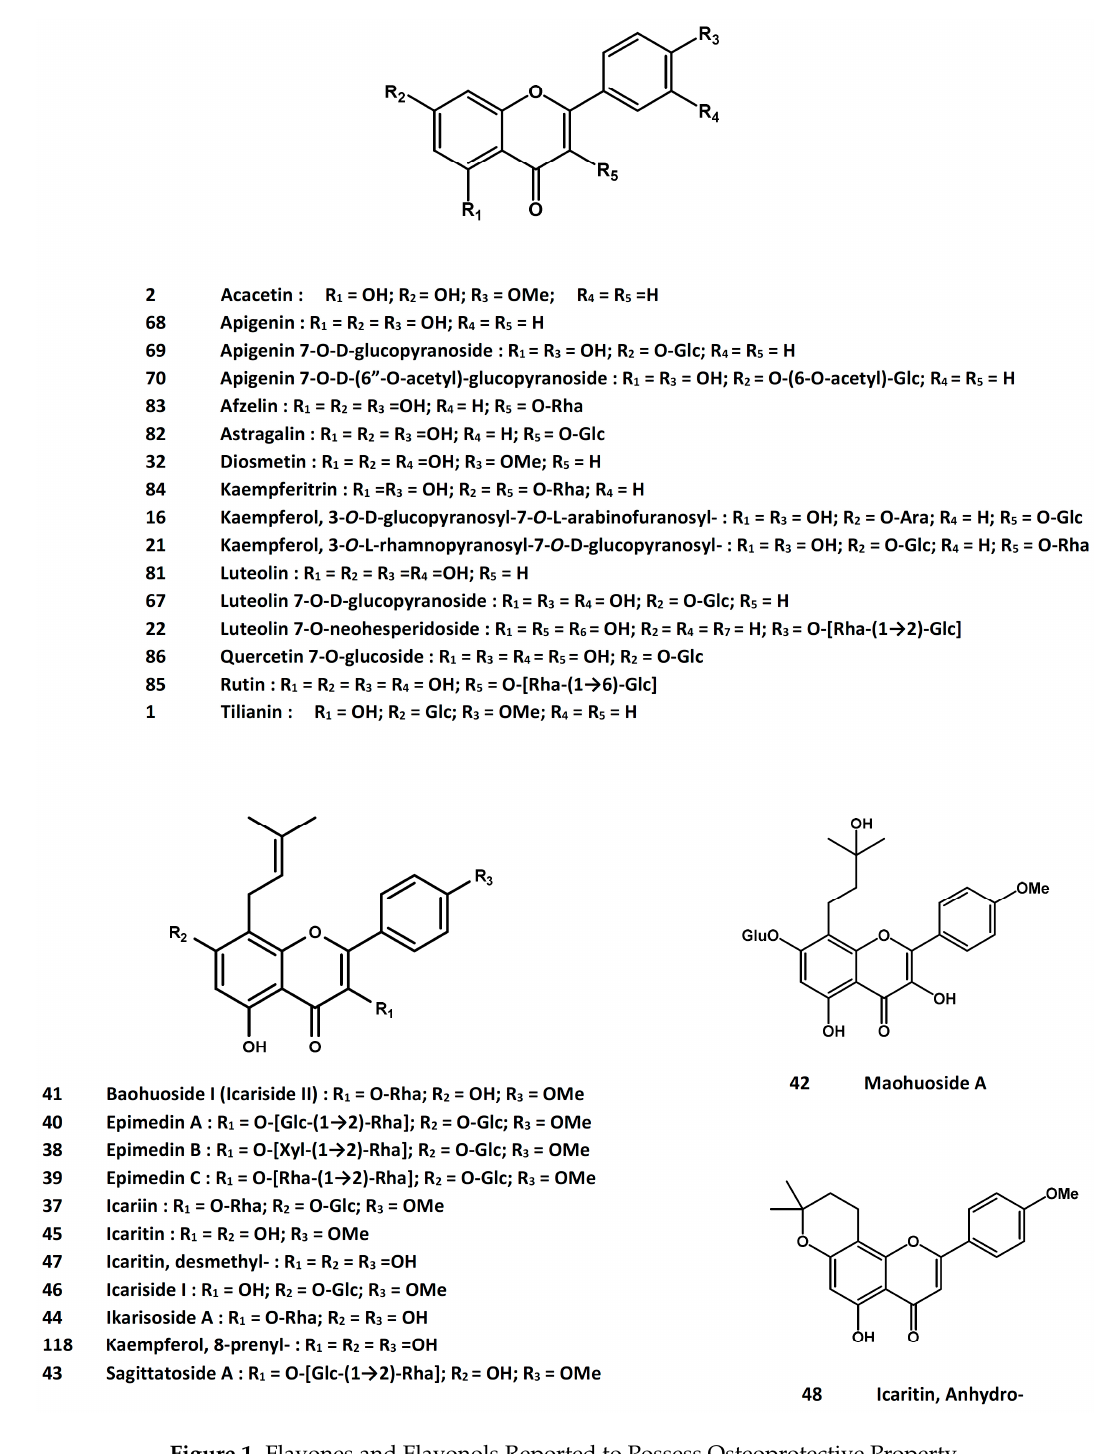
Figure 1. Flavones and Flavonols Reported to Possess Osteoprotective Property.